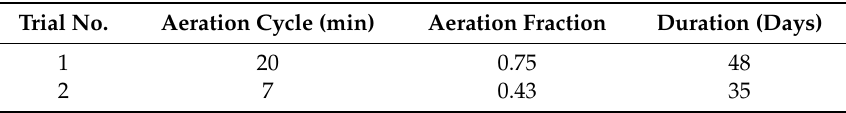
Table 2. Intermittent aeration cycle trials and aeration fraction details.